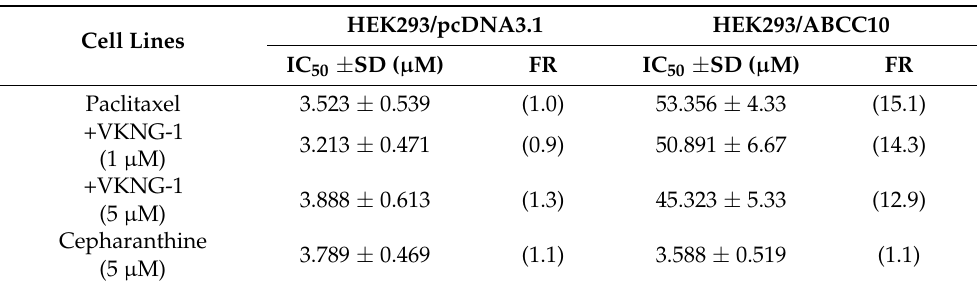
Table 5. The reversal effect of VKNG-1 on the cytotoxicity of anticancer drugs in ABCC10-transfected cell